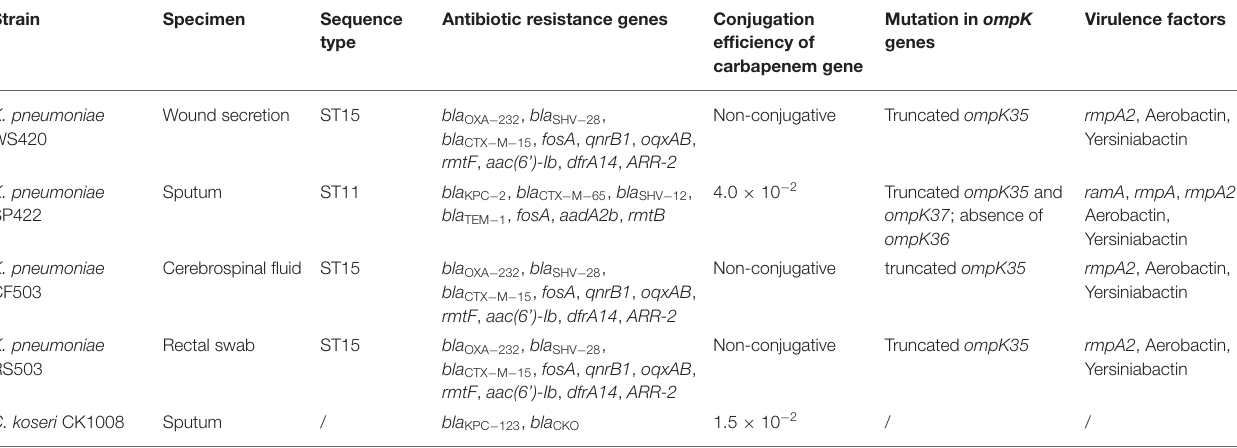
TABLE 1 | Characteristics and carriage of antibiotic resistance genes of C. koseri CK1008 and four K. pneumoniae isolates.